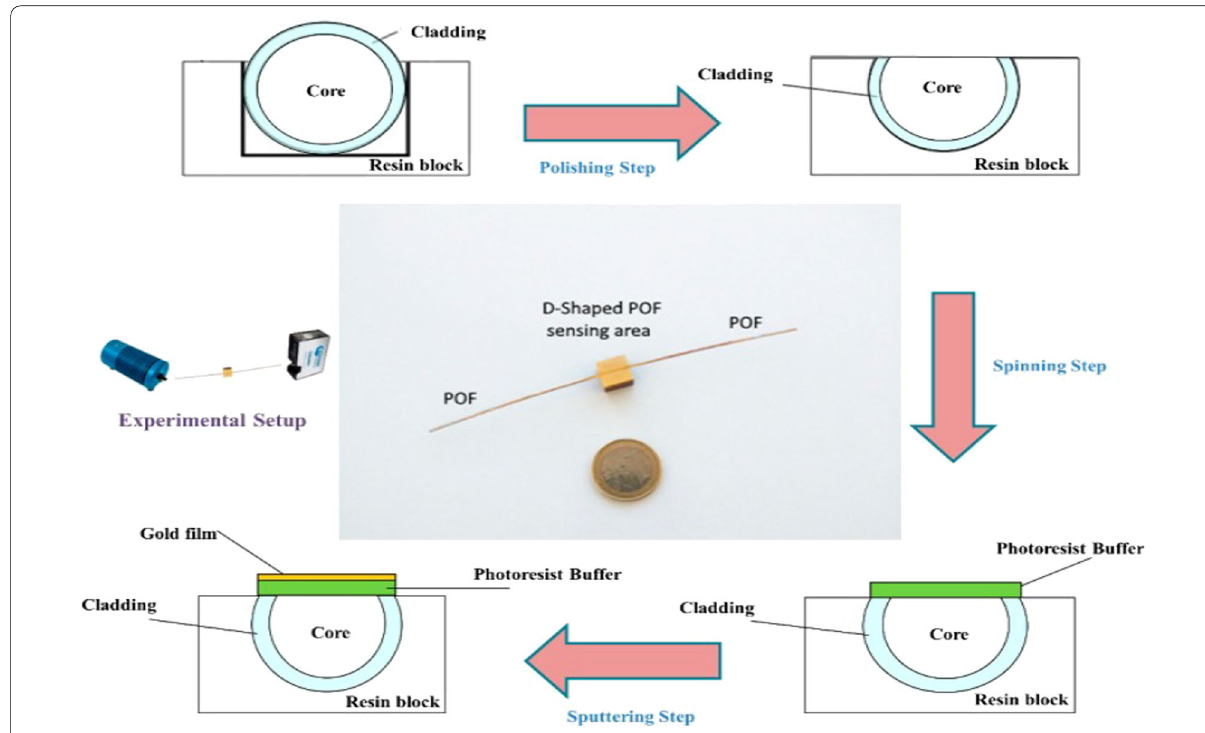
Fig. 7 Mechanism of Optical Fiber Chemical sensor (Pesavento et al.